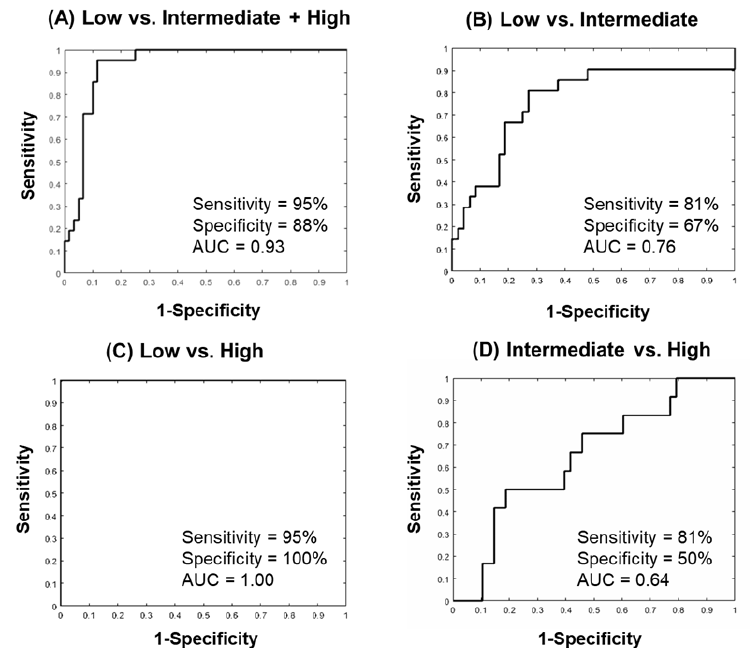
Figure 6. The Area under the Curve (AUC) graphs of the single IsoSVM model trained using quantitative imaging parameters (PK-DCE, ADC), Ki67, and single radiomics (FOS Entropy, Uniformity; GLCM Entropy, Energy) with the OncotypeDX score compared to each group. ( A ) The low versus intermediate + high-risk group. The sensitivity was 95% and specificity was 88% with an AUC = 0.93 (CI = 0.88–0.99). ( B ) The low versus intermediate risk group resulted in a sensitivity of 81%, specificity of 67%, and an AUC = 0.76 (CI = 0.63–0.90). ( C ) The low versus high risk group resulted in a sensitivity of 95%, specificity of 100%, and an AUC = 1.00 (CI = 1.00–1.00). ( D ) The intermediate versus high risk group resulted in markedly lower (non-diagnostic) AUC and other metrics with a sensitivity of 81%, and specificity of 50%, and an AUC = 0.64 (CI = 0.47–0.81). Gray Level Co-occurrence Matrix (GLCM).